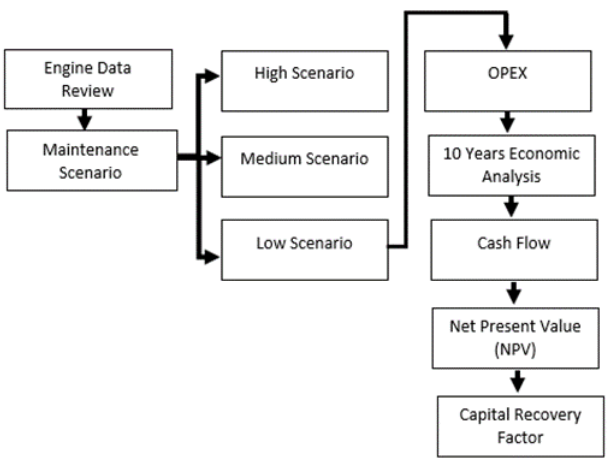
Figure 7. Marine fuel price differentials.